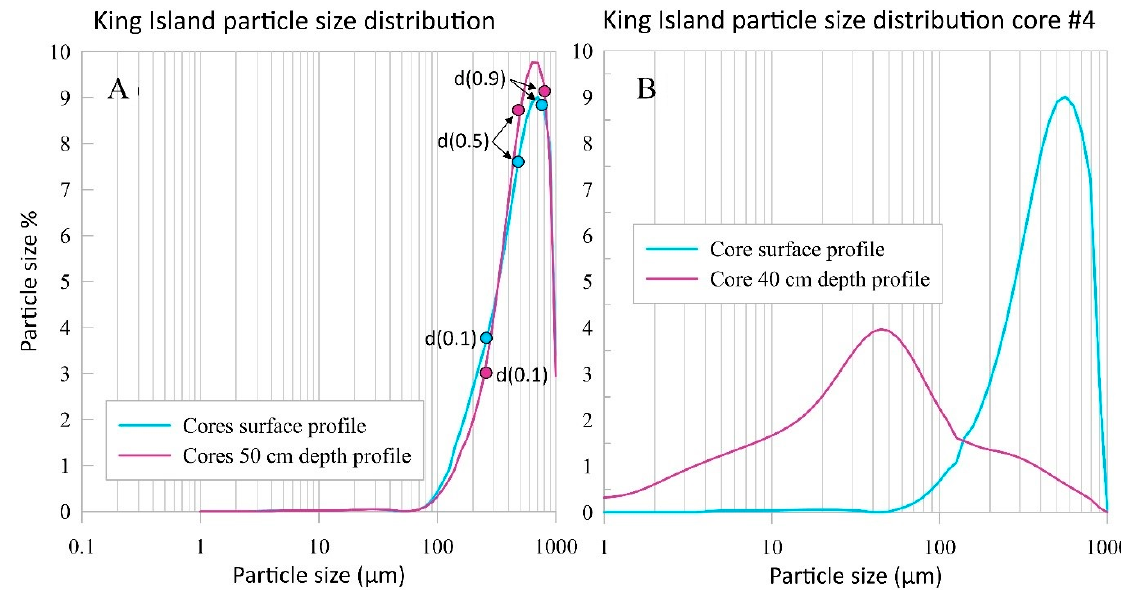
Figure 5. ( A ) Particle size distribution of the seabed sand and 40–50 cm depth, averaged from 10 core samples. ( B ) Core #4 showing the fine particles at the base, likely organics preserved from lower sea levels.